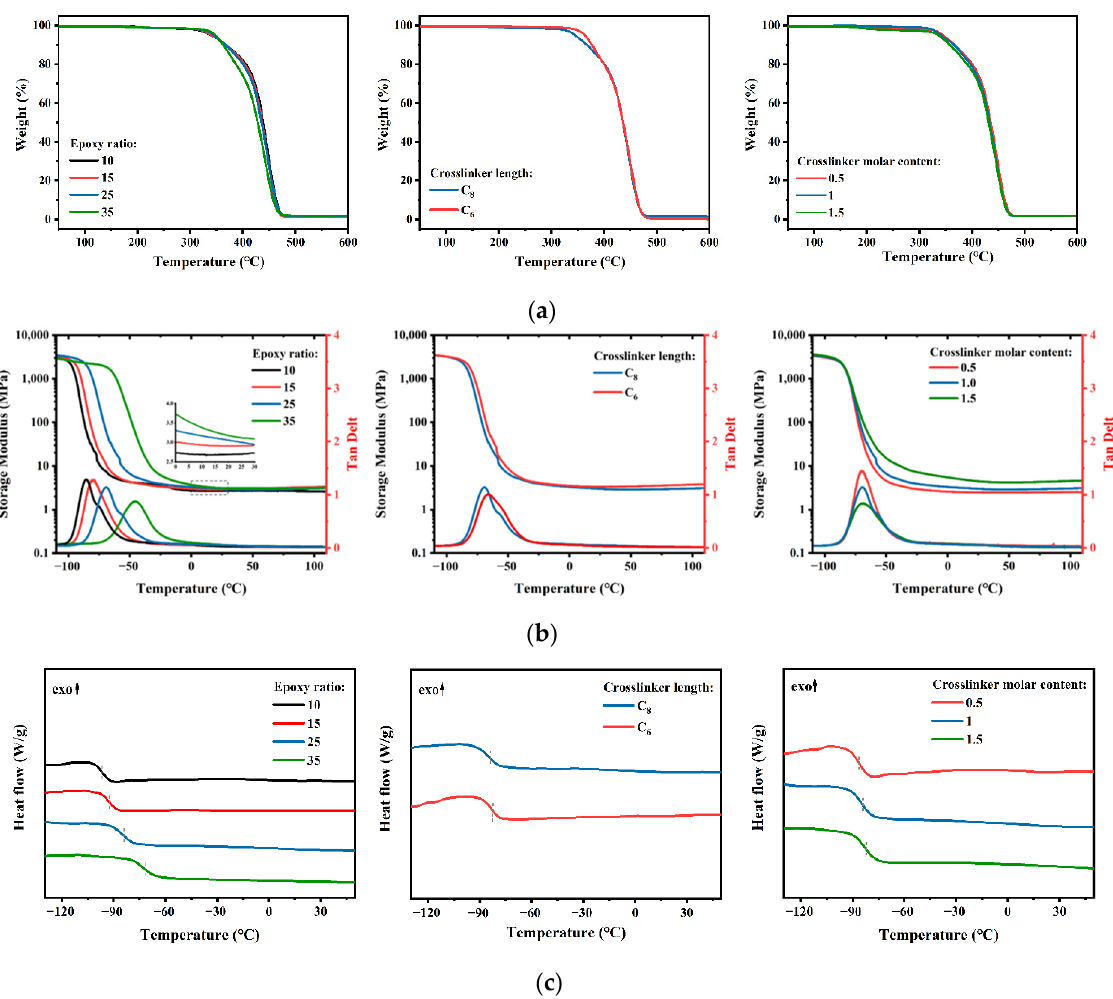
Figure 2. ( a ) TGA profiles, ( b ) DMA curves, and ( c ) DSC thermograms for PB vitrimers with the modification of network parameters.